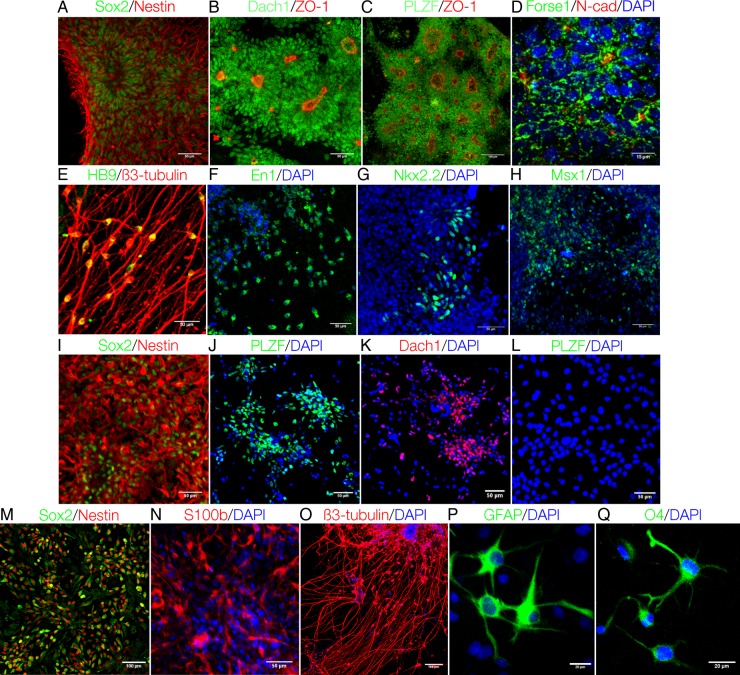
Characterization of rESC-derived NSCs. The common NSC markers Nestin and Sox2 (A); the specific markers Dach1 (B) and PLZF (C), and the polarized distribution of ZO1 in R-NSCP1 (B and C); the co-expression of Forse1 and N-cad in R-NSCP1 (D); R-NSCP1 can be coaxed to undergo posterior (E), anterior (F), ventral (G), and dorsal patternings (H). R-NSCP6 cells expressed Sox2 and Nestin (I), PLZF (J), and Dach1 (K). Glial-like NPCs did not express PLZF (L), but expressed Sox2 and Nestin (M), specific marker S100b (N), and can differentiate into neurons (O), astrocytes (P), and oligodendrocytes (Q).